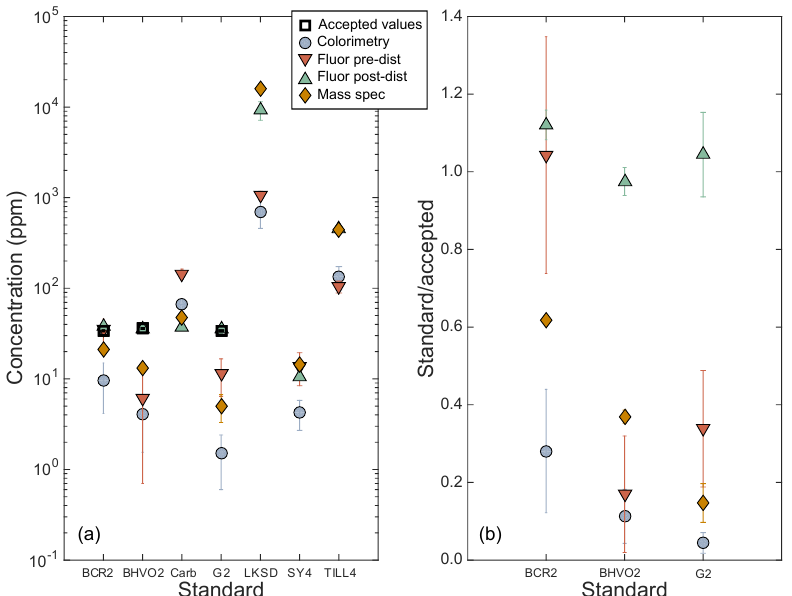
Figure 2. (a) Comparison of N concentrations in rock standards from three different methods. Colorimetry consistently yields lower values than fluorometry, and values are typically lower than EA mass spectrometry. Fluorometry and EA mass spectrometry give similar results for sedimentary rocks (LKSD-4, Till-4, 5.1) but tend to differ for crystalline rocks (BCR-2, BHVO-2, SY-4, G-2), with fluorometry giving higher concentrations. (b) Though associated errors are larger, fluorometry does reproduce published N concentration values from three standards (BCR-2, BHVO-2, G-2), especially after distillation. The legend is the same in both (a) and (b) .